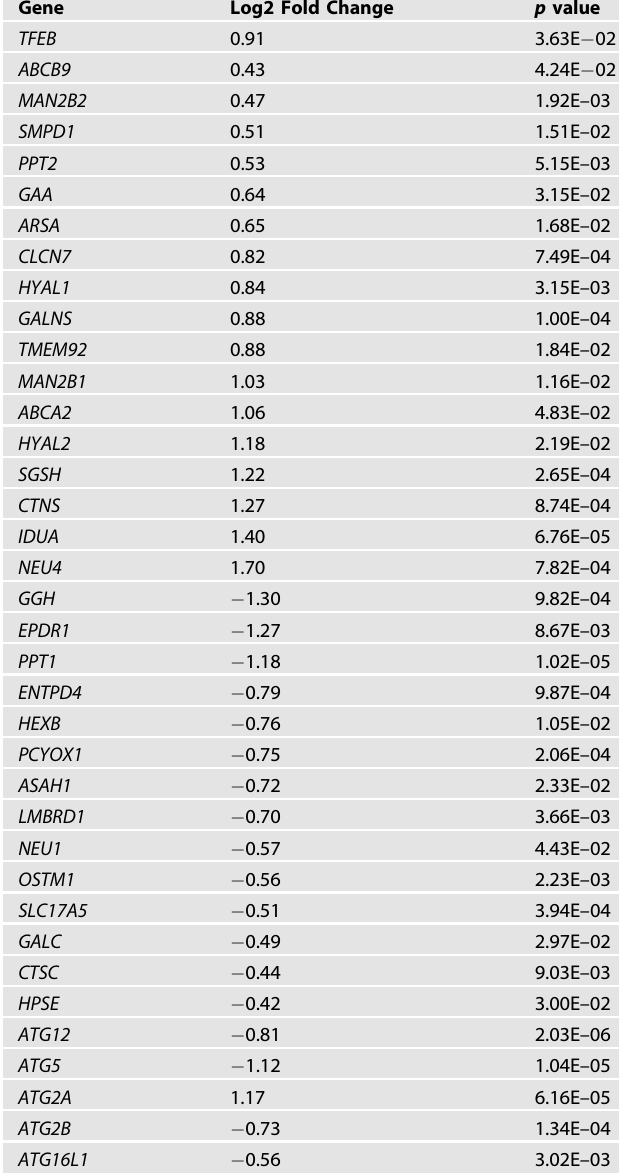
Table 1. Lysosomal genes are differentially expressed in brains from MAPT p.R406W